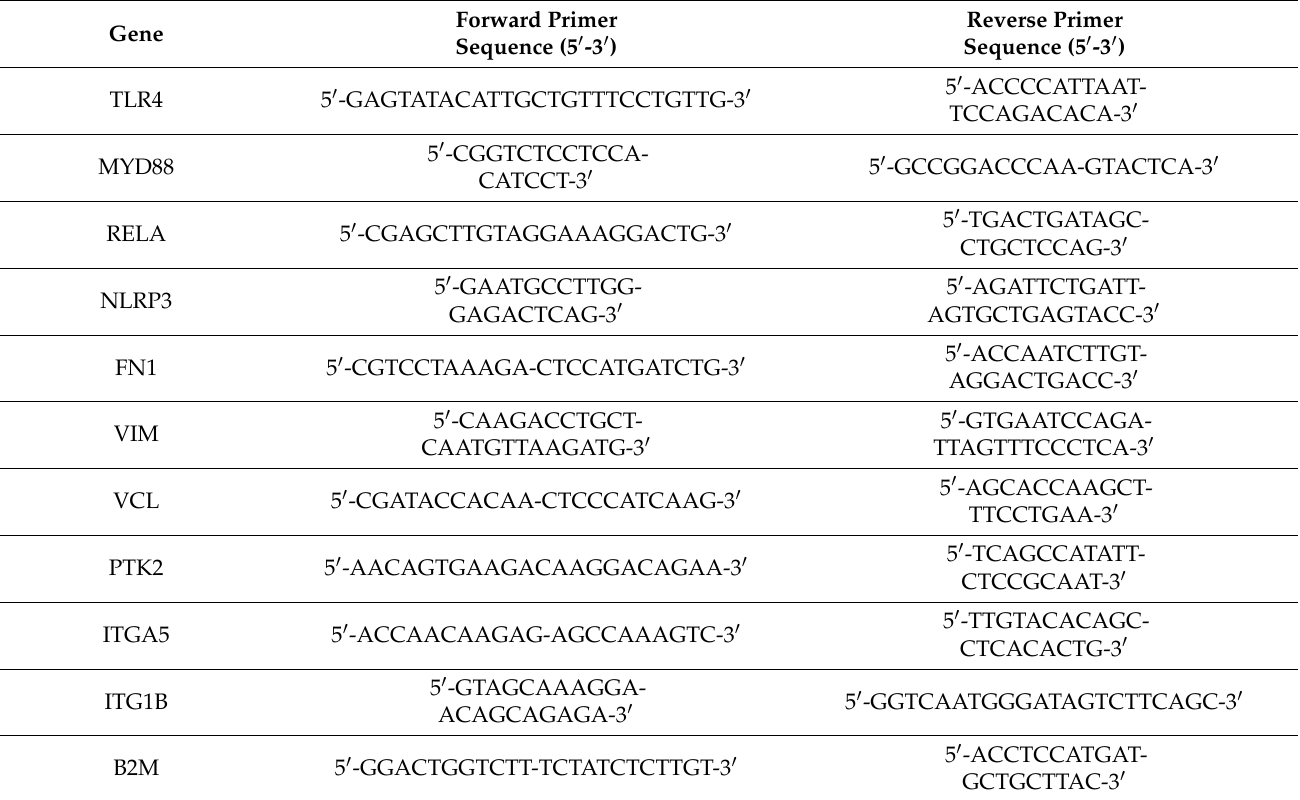
Table 1. Primer sequences used for real-time PCR